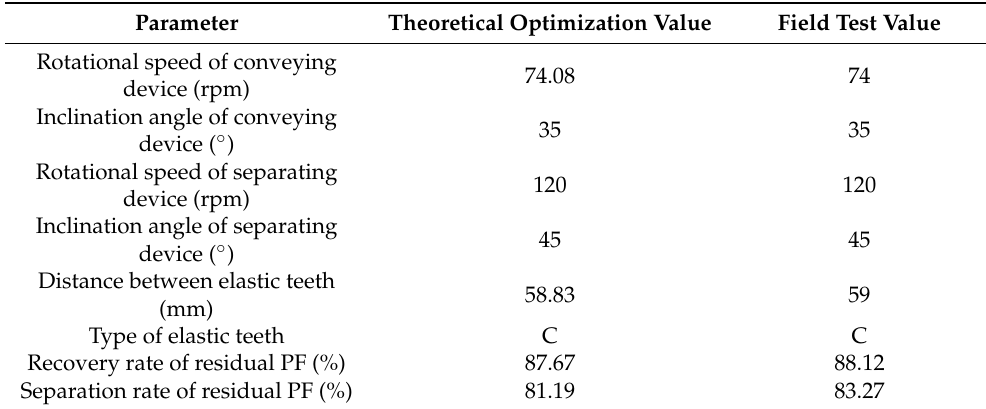
Table 1. Compare the theoretical optimization results of recovery and separation rate with the field test